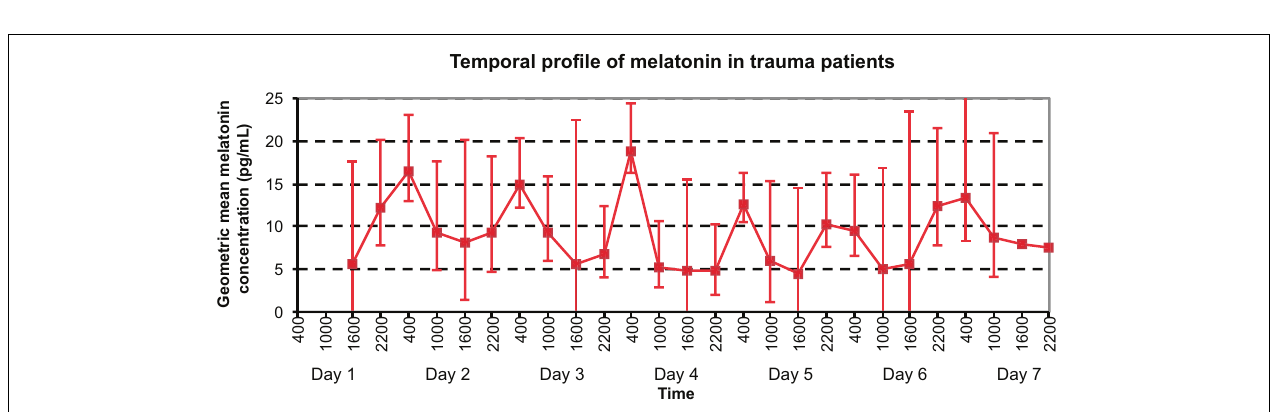
FIGURE 2 |Temporal profile of geometric mean serum melatonin concentrations in trauma patients withoutTBI, with peaks at 0400h on Days 2, 3, 4, 5, and 7, and nadir at 1600h on Day 5 .